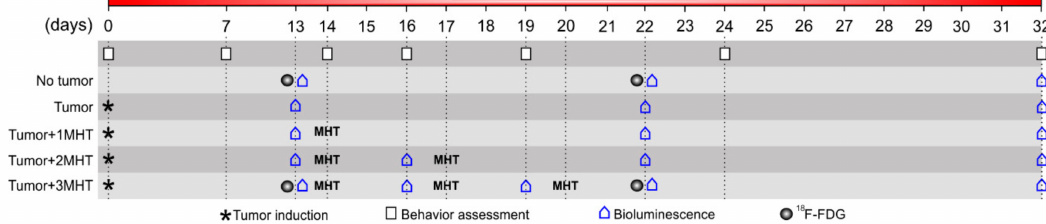
Figure 10. Experimental design, in vivo, for multiple MHT applications performed in 5 experimental groups: No_Tumorgroup, Tumorgroup, Tumor + 1MHTgroup, Tumor + 2MHTgroup, andTumor + 3MHT group were evaluated the therapeutic efficiency by BLI, 18 F-FDG-PET / CT, and behavior. In Vivo MHT Therapeutic